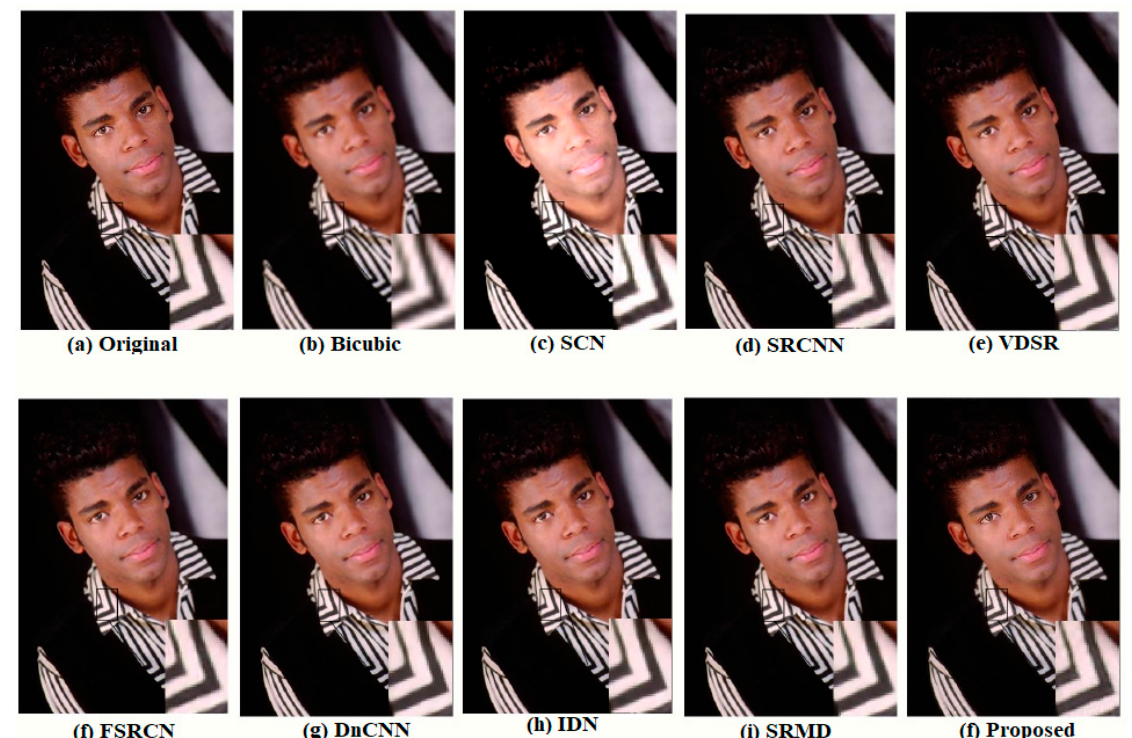
Figure 9. Visual comparison for the man image at the scale-up factor of 3.